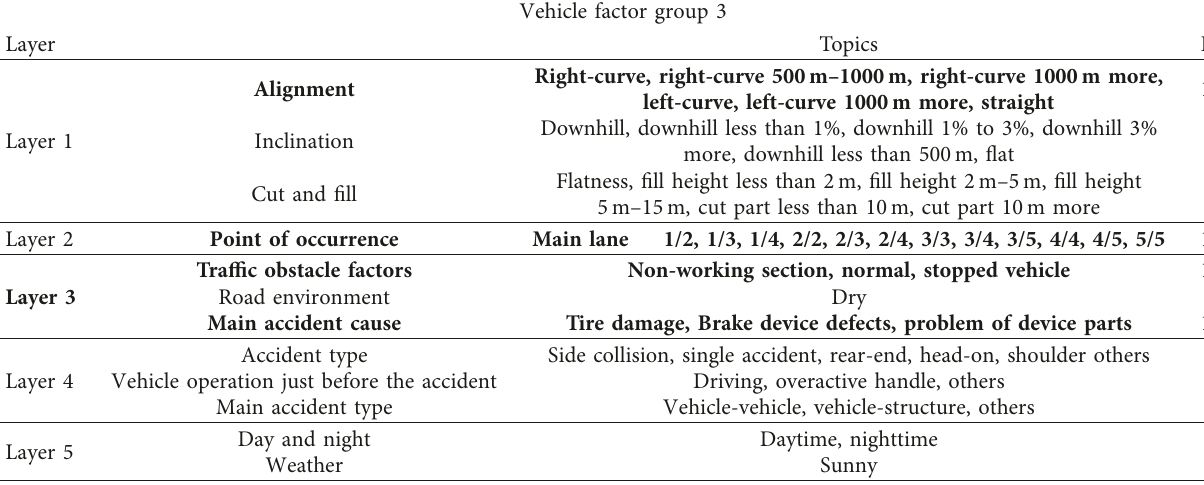
Table 7: Vehicle factor topic modeling group 3.